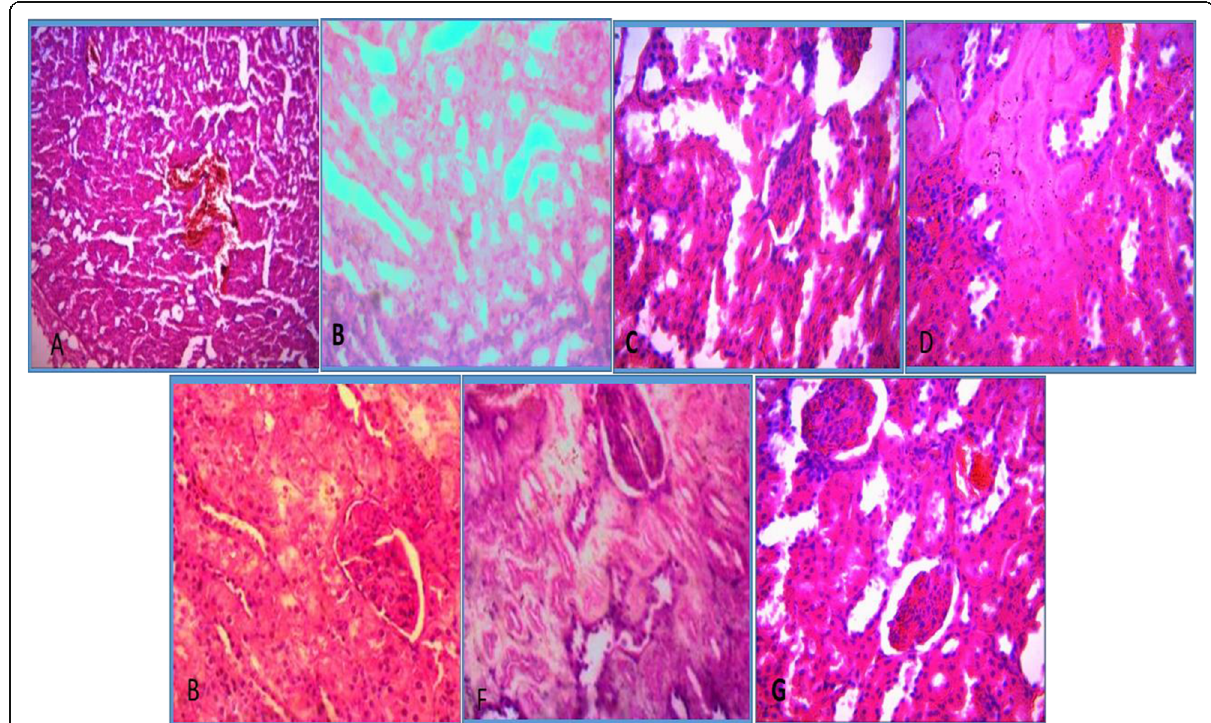
Fig. 5 Photomicrograph slides of rat Kidney (Hematoxylin and eosin staining, 100x magnification). A: Liver of Diabetic control; B: Liver of Obese diabetic control; C: Liver of Obese diabetic rats treated with 10% Pleurotus tuber-regium ; D: Liver of Obese diabetic rats treated with 20% Pleurotus tuber-regium ; E: Liver of Drug control rats; F: Liver of Obese control rats; G Liver of Normal control